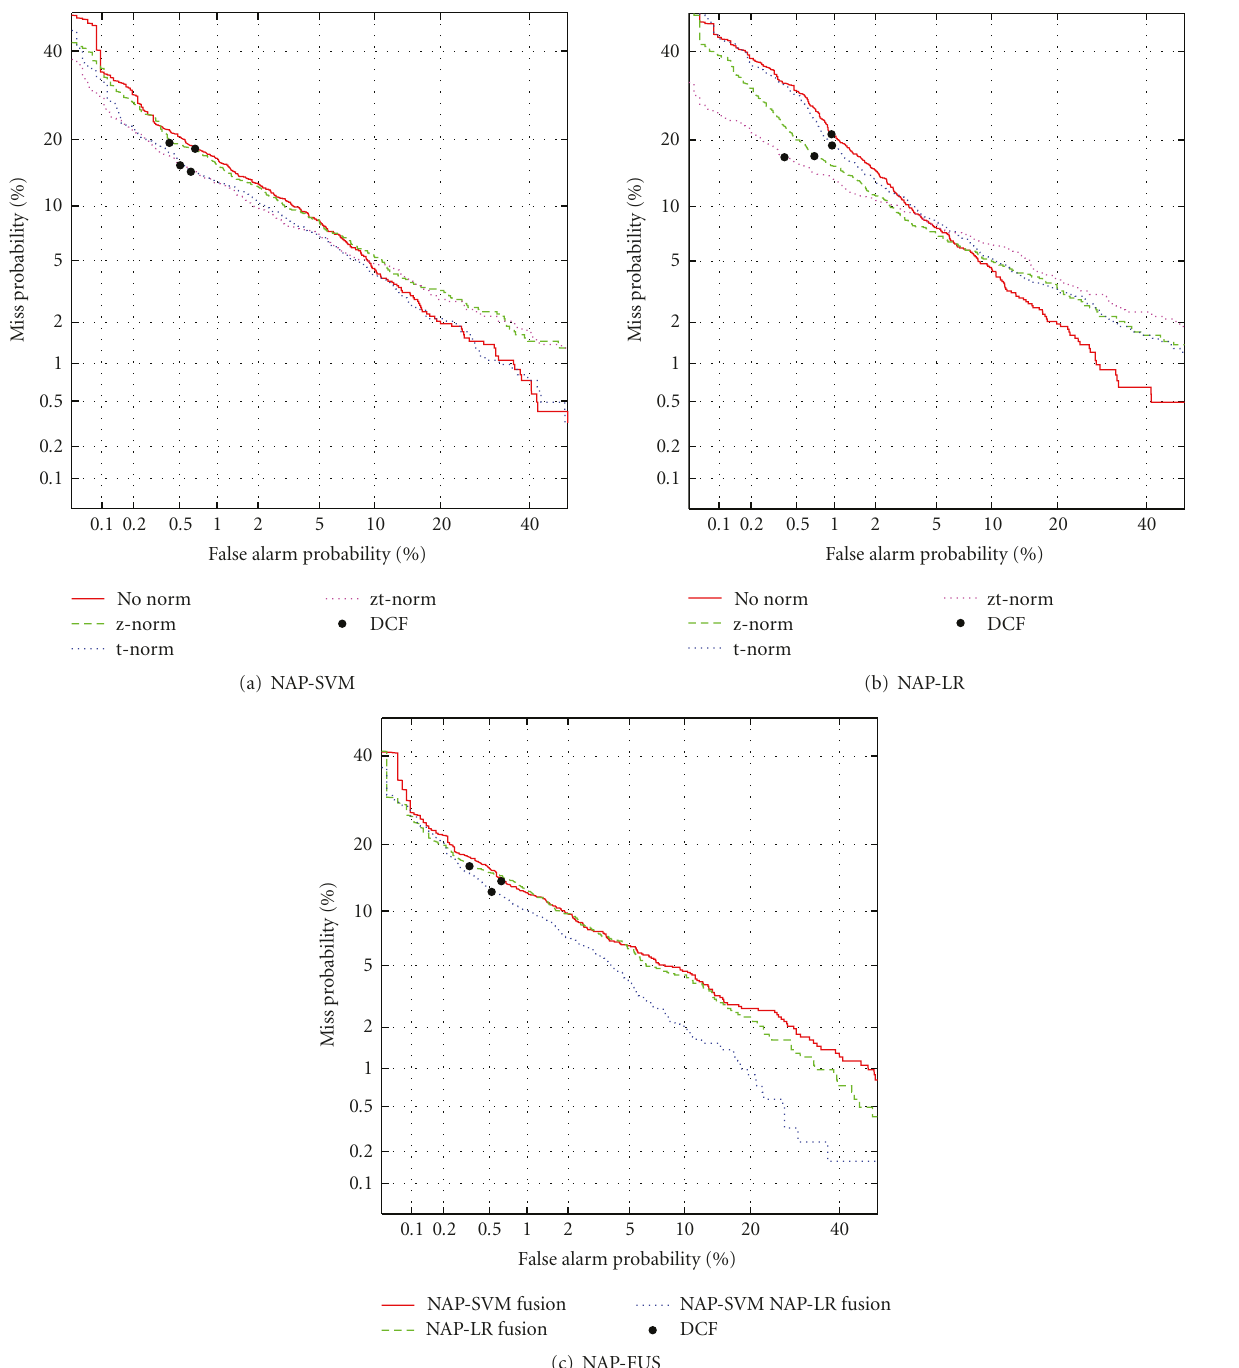
Figure 3: Speaker verification results of the NAP-based systems. The DET curves for (a) the SVM and (b) LR decision criteria as well as (c) their fusion are shown. The black circle on each DET curve represents the DCF